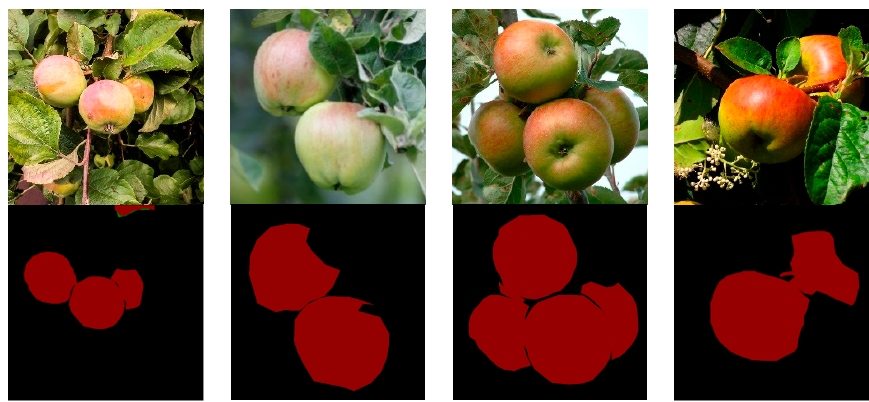
Figure 7. Apple images with complex backgrounds and their labels.